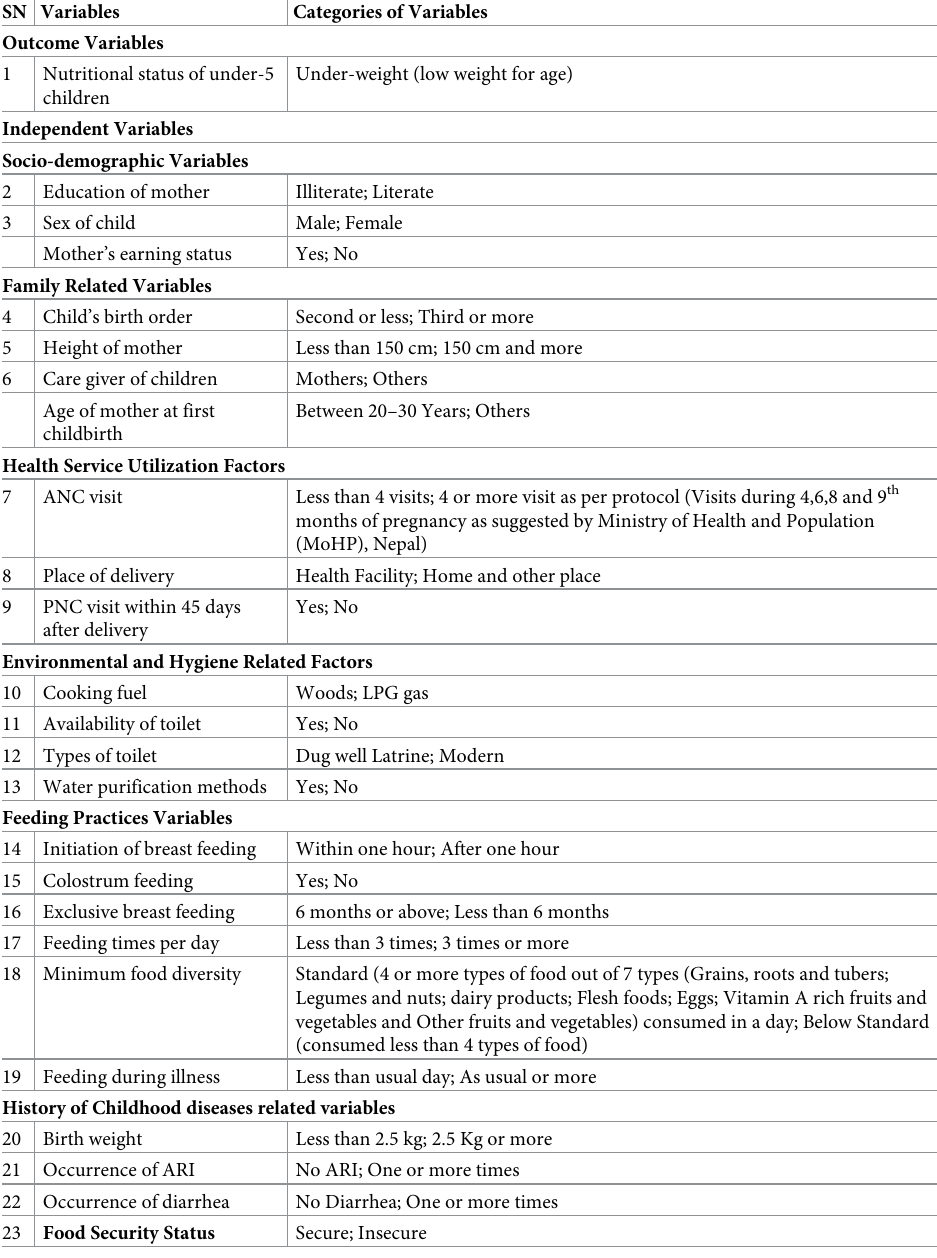
Table 1. Categories of variables under